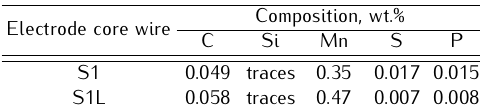
Table 2. Chemical composition of SpG1-grade electrode cores (EN ISO 14171-A – S1). Electrode core